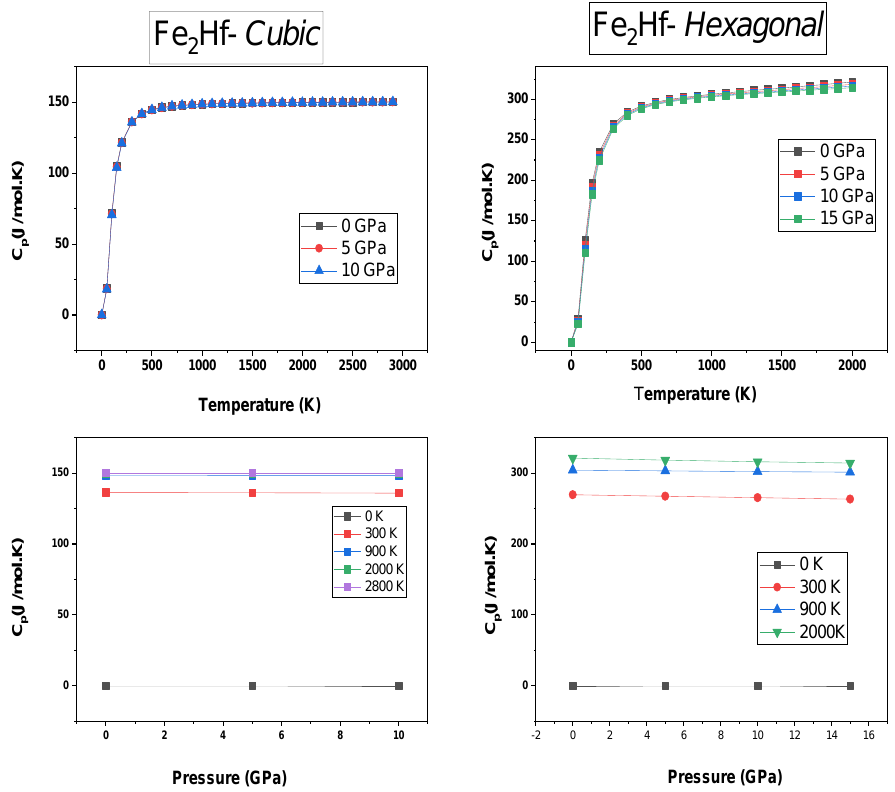
Fig. 8. Variation of constant pressure heat capacity C P with temperature T and pressures for c- Fe 2 Hf and h- Fe 2 Hf (upper panel)